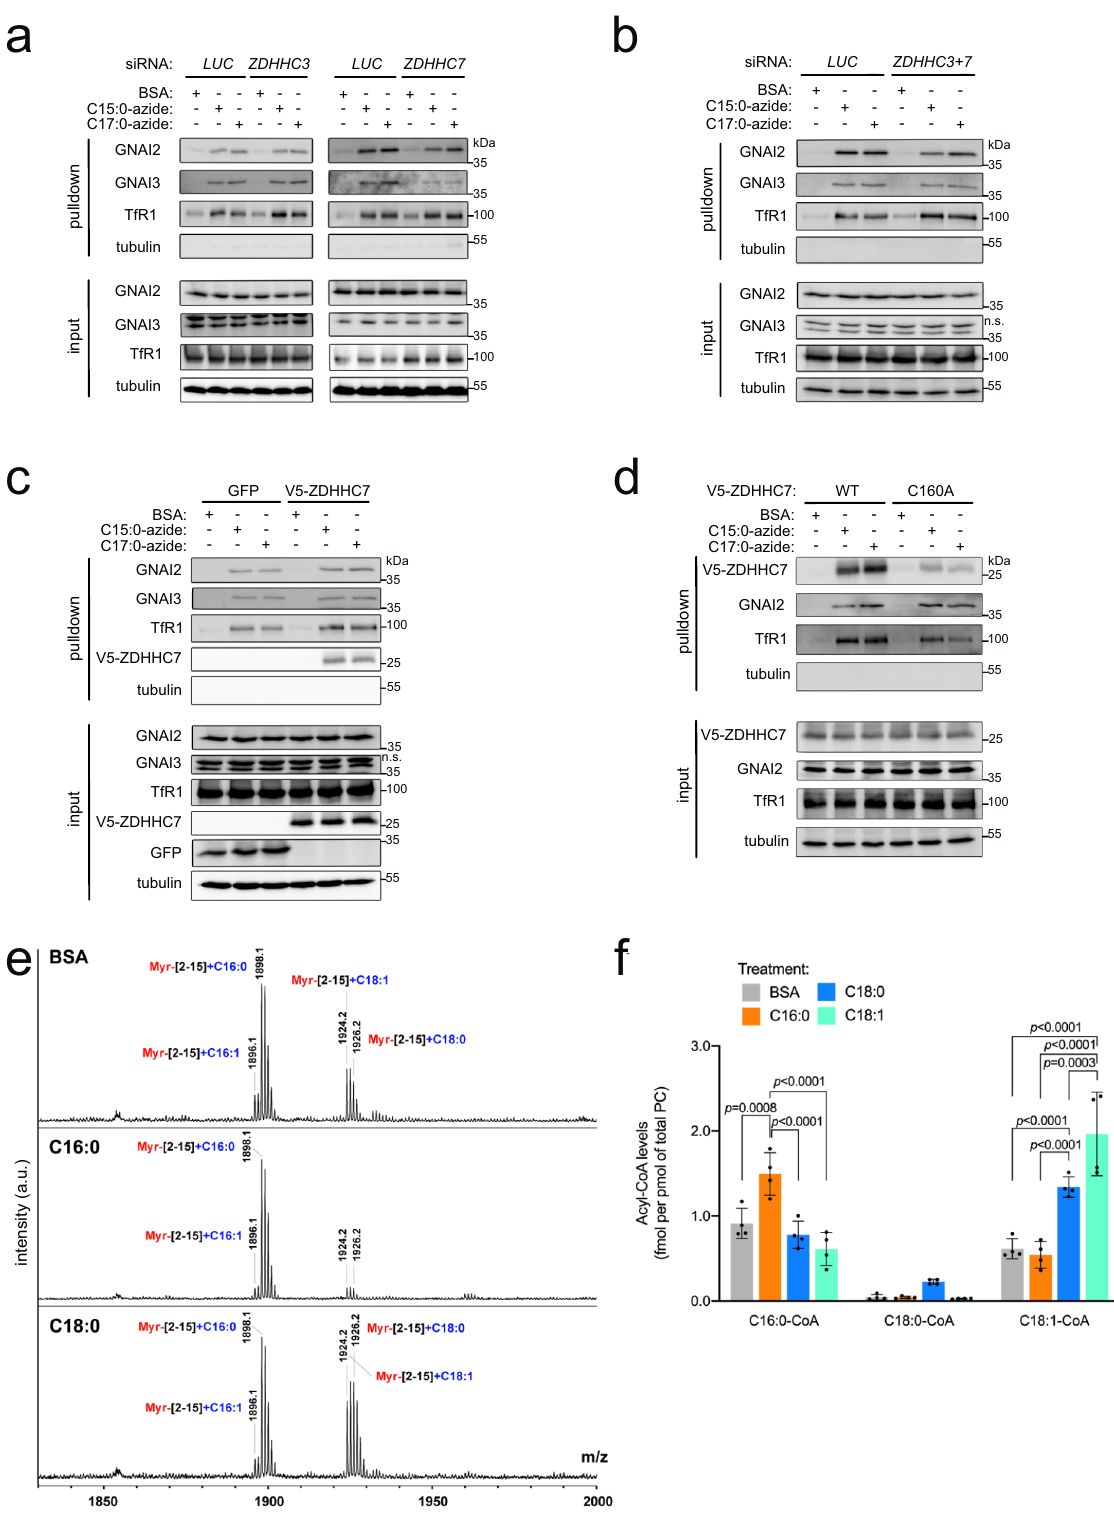
EGFR, this raises the possibility that C18:0 inhibits the ability of GNAIs to potentiate EGFR signaling. Consistent with this, treatment of cells with either C18:0 or C18:1 for 3 h reduced Gab1 recruitment to EGFR (Fig. 5c). After 24 h of treatment with lipids, C18:0 still reduced Gab1 recruitment (Supplementary Fig. 5d) whereas C18:1 did not (Supplementary Fig. 5e), perhaps because C18:1 is metabolized more rapidly 66 . To test whether C18:0